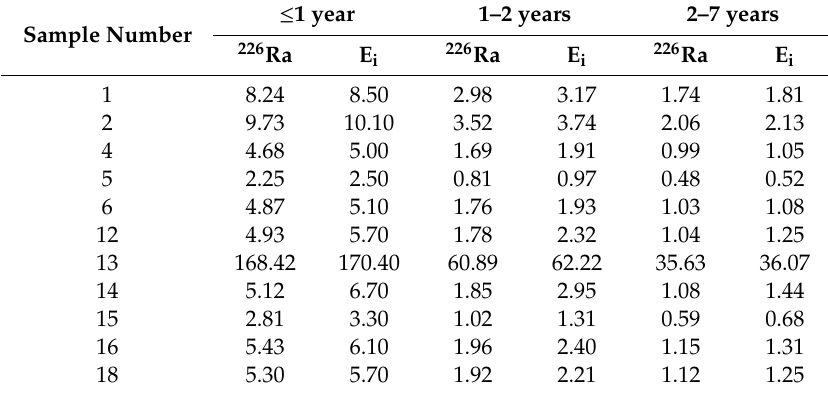
Table 3. E ff ective doses (in µ Sv) from all the radioisotopes contained in water samples—E i and 226 Ra contribution to this dose received by infants, children aged 1–2 and 2–7 years as a result of inhalation of mineral water.